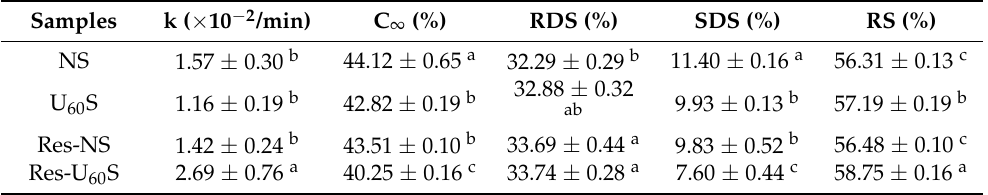
Table 3. Kinetic parameters and starch fraction of simulated GIT digestion of different samples. Samples